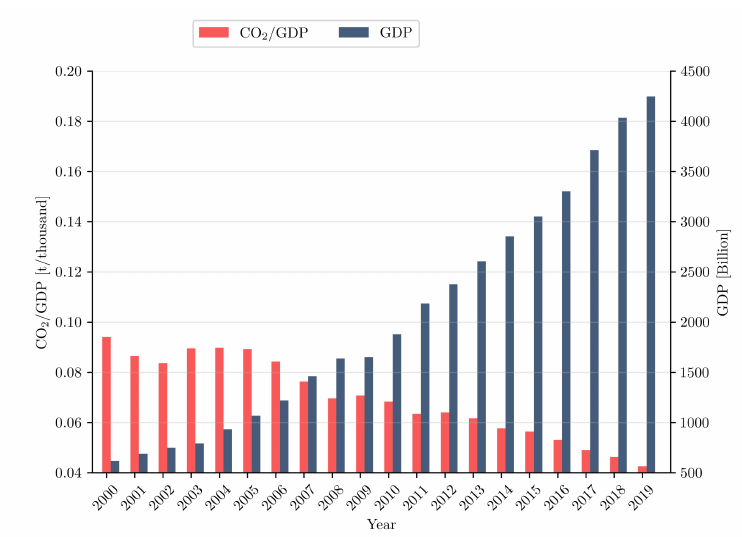
Figure 2. Added value and carbon intensity of China’s logistics industry in